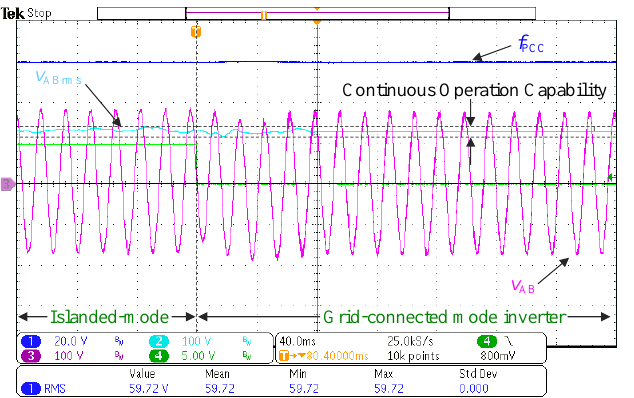
Figure 18. The transition from islanded operation mode to grid-connected mode on the prototype.